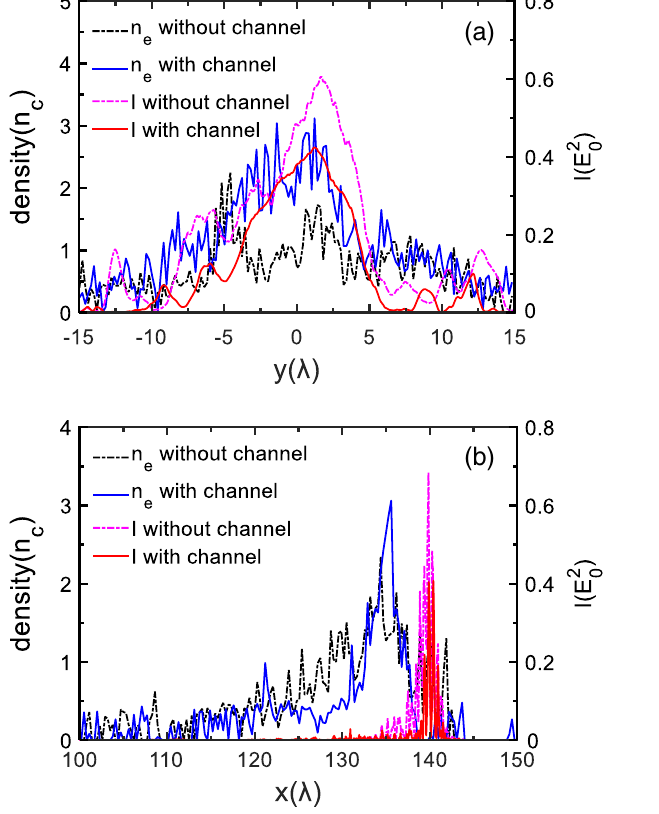
FIG. 5. (a) Transverse profiles of electron density and laser intensity along the x ¼ 135 λ and x ¼ 140 λ , respectively. (b) Longitudinal profiles of electron density and laser intensity both along the y ¼ 0 . Dashed and solid lines represent the cases without a channel and with a channel, respectively. Snapshots correspond to the moment t ¼ 500 fs.